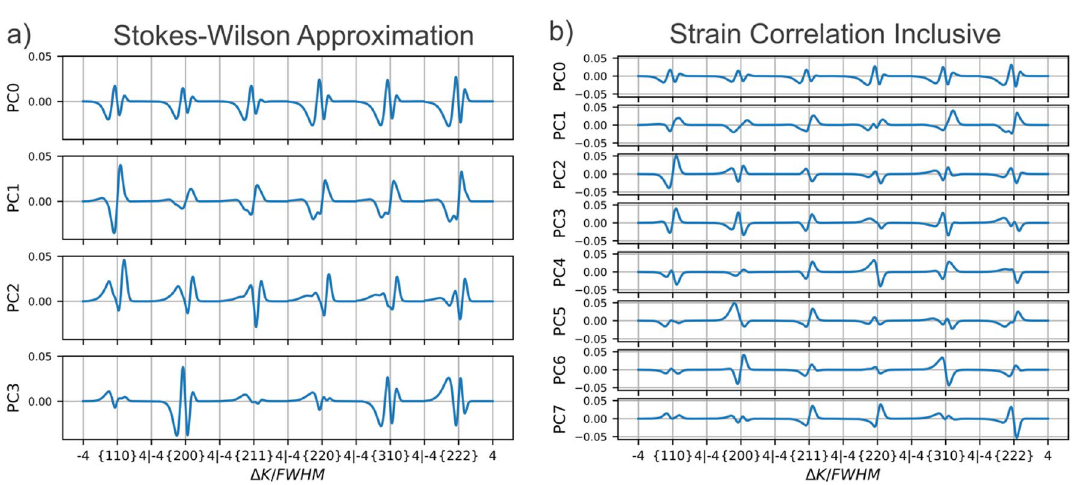
Figure 12. The principal components (PCs) which were used to approximate profile shape for the two different profile databases. The components are given in order of decreasing relative contribution to the total variance of the